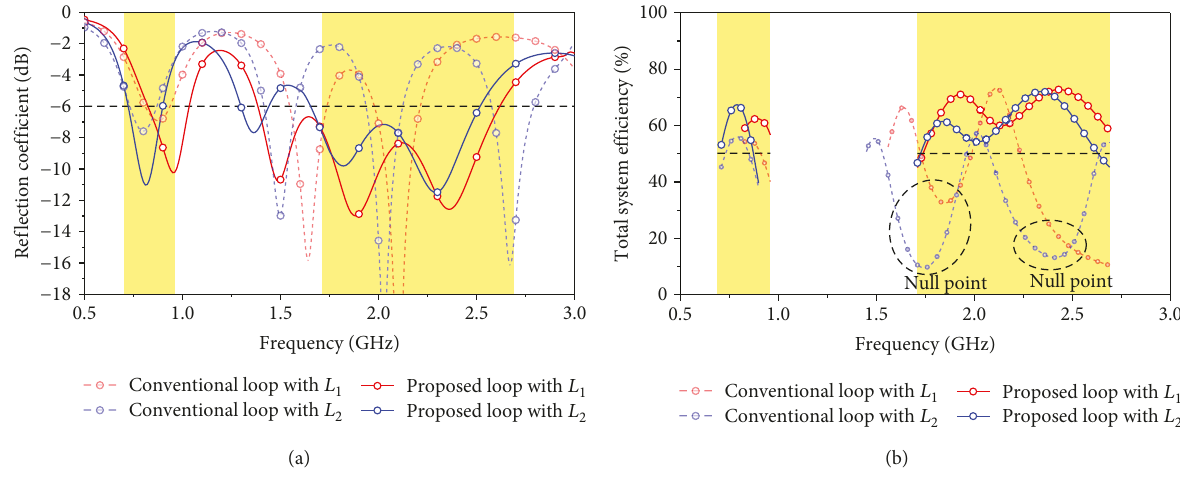
Figure 3: Simulated (a) re fl ection coefficient and (b) total system efficiency of the proposed antenna in comparison with the reference loop